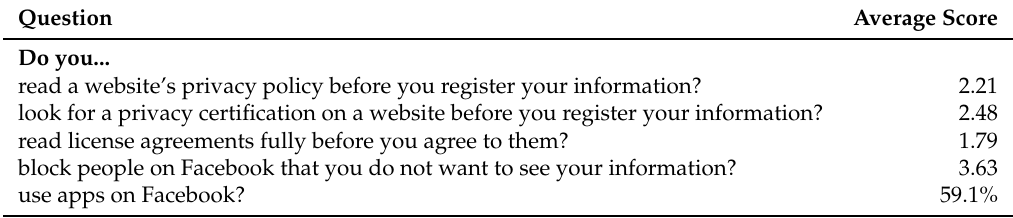
Table 1. Questions regarding general online privacy concerns. Each question is rated on a 5 point Likert scale from “Never” (1) to “Always” (5), except for the final question which is shown as the percentage of yes answers. Question Do